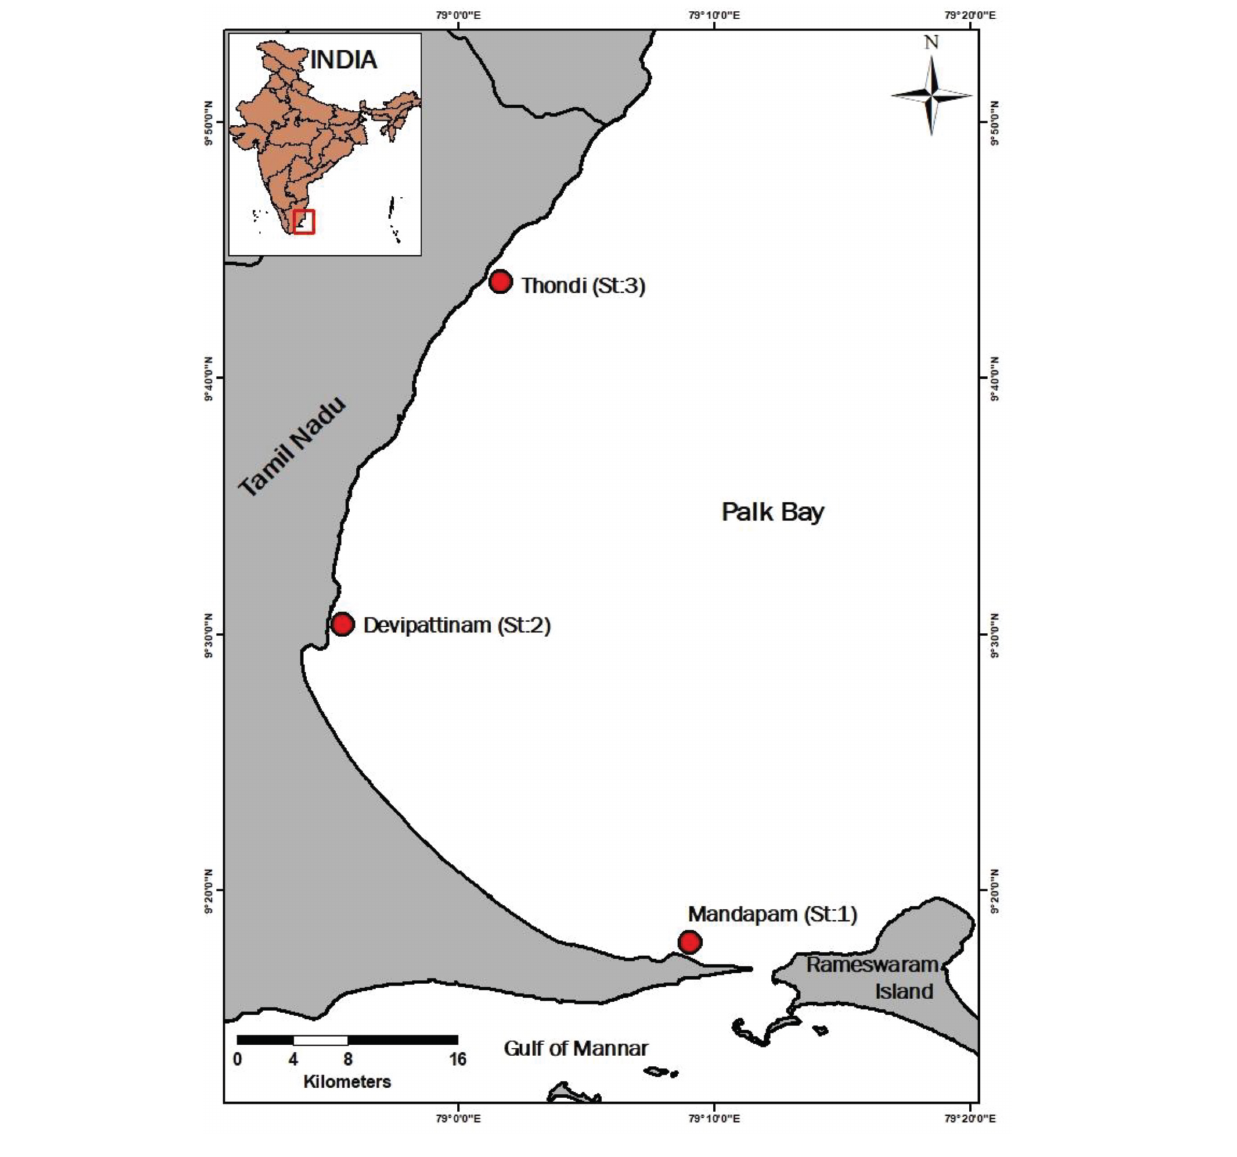
FIGURE 1 | Map of Palk Bay showing the sampling